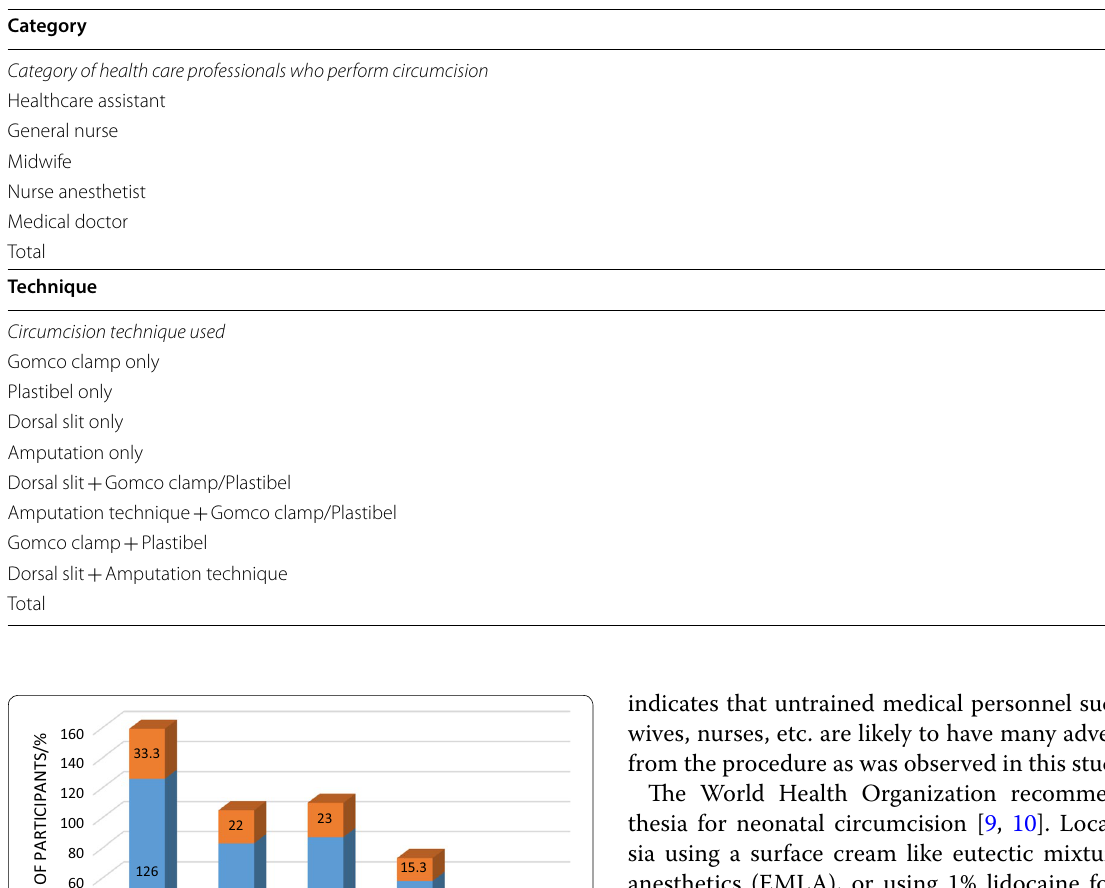
Table 1 Distribution of health care professionals and circumcision techniques used